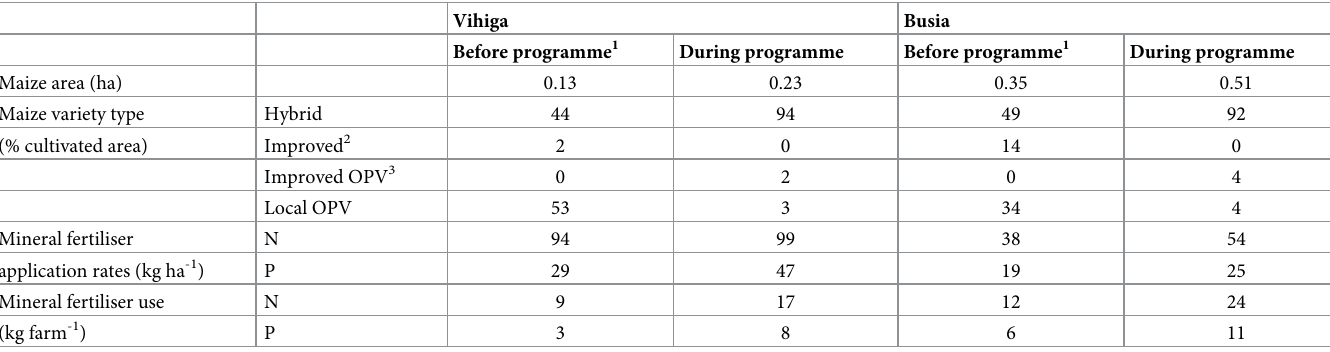
Table 1. Average farm-level maize input use and productivity in the two seasons before the programme and the five seasons during the programme. Vihiga Busia Before programme 1 During programme Before programme 1 During programme Maize area (ha) 0.13 0.23